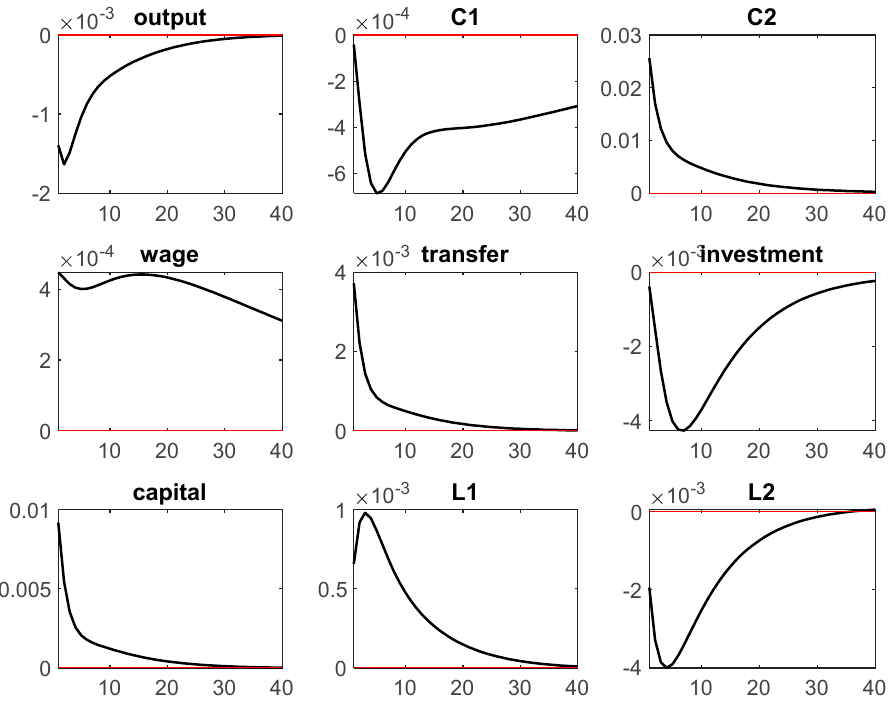
Figure 2. The effects of fiscal policy (capital tax rate reduction) on Korean key macroeconomic variables.